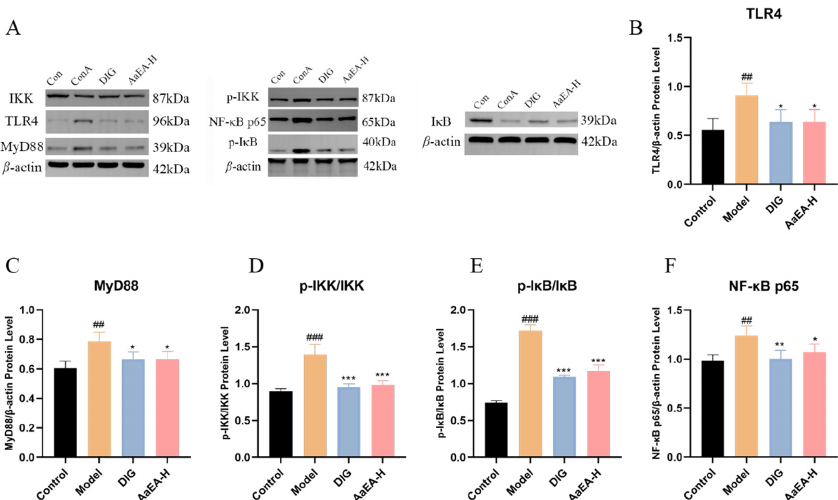
Figure 8. Effects of AaEA-H on regulating the key proteins of the TLR4/MyD88/NF- κ B pathway (n = 3). Western blot analysis of protein expressions of TLR4, MyD88, p-I κ B, I κ B, p-IKK, IKK, and NF- κ B p65 ( A ). TLR4 level normalized with β -Actin ( B ). MyD88 level normalized with β -Actin ( C ). The ratio of p-IKK protein expression level to IKK protein expression level ( D ). The ratio of p-I κ B protein expression level to I κ B protein expression level ( E ). NF- κ B p65 level normalized with β -Actin ( F ). Unless indicated, no significant difference was observed between groups. Compared with control group, ## p < 0.01 and ### p < 0.001. Compared with ConA group, * p < 0.05, ** p < 0.01 and *** p < 0.001.